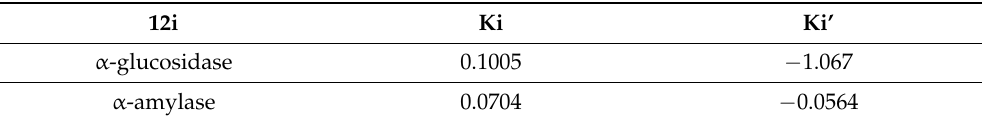
Table 3. Kinetic parameters of α -glucosidase and α -amylase enzymes against 12i and its various concentrations. 12i Ki